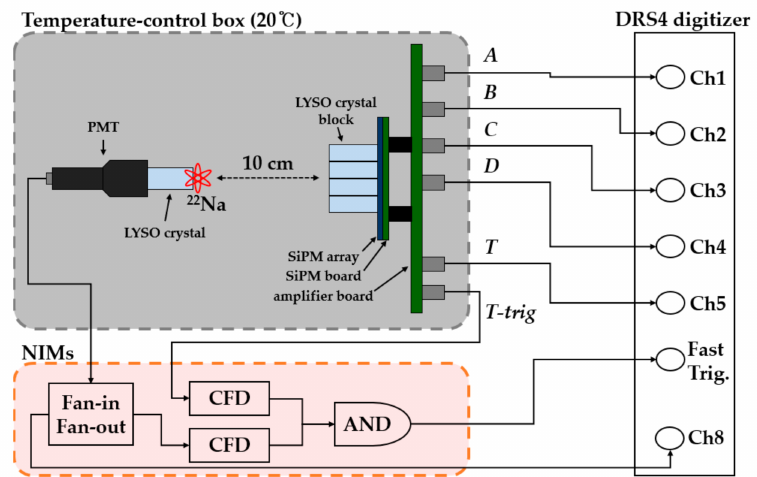
Figure 3. Experimental setup.